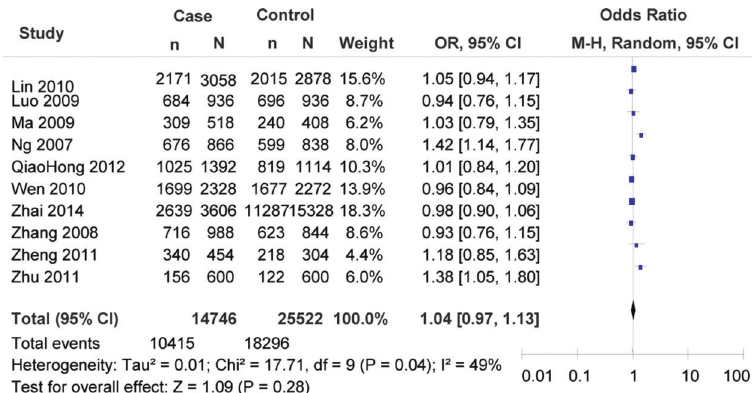
Figure 2 - Meta-analysis of the association between the rs11196218A/G polymorphism and T2DM risk (G vs. A). n indicates the total number of G alleles, and N indicates the total number of G alleles plus A alleles.